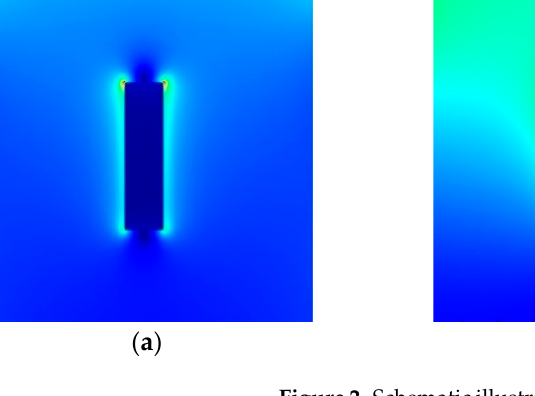
Figure 2. Schematic illustrations of NR FDTD simulations. The examples show theoretical simulations for NRs without a SiO 2 shell [( a )–cylinder (Au) height-70 nm, radius-10 nm, excitation wavelength-532 nm)], for NRs with a SiO 2 shell [( b )–cylinder (Au) height-70 nm, radius-15 nm, the thickness of SiO 2 -3 nm, excitation wavelength-532 nm)], and a single (hollow) SiO 2 shell [( c )–height-70 nm, the thickness of SiO 2 -3 nm, radius-15 nm, and excitation wavelength-532 nm].